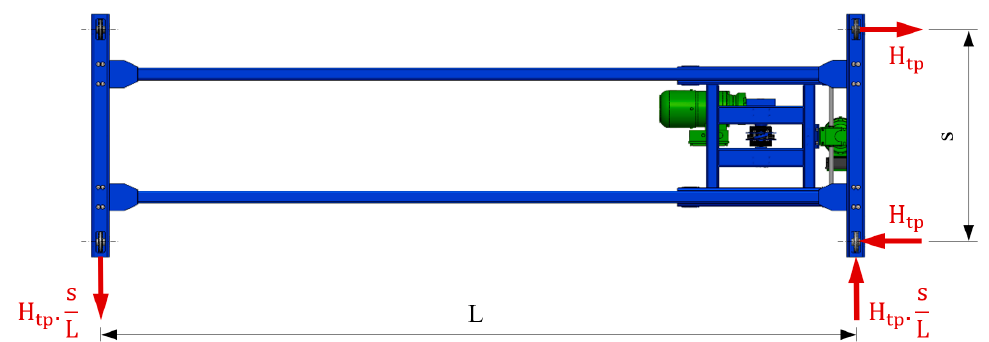
Figure 2. Action scheme of forces caused by crane bridge skewing. H tp —force causing the crane skewing, L—span of the crane, s—wheelbase of the crane wheels. The most common causes of uneven operation of the crane